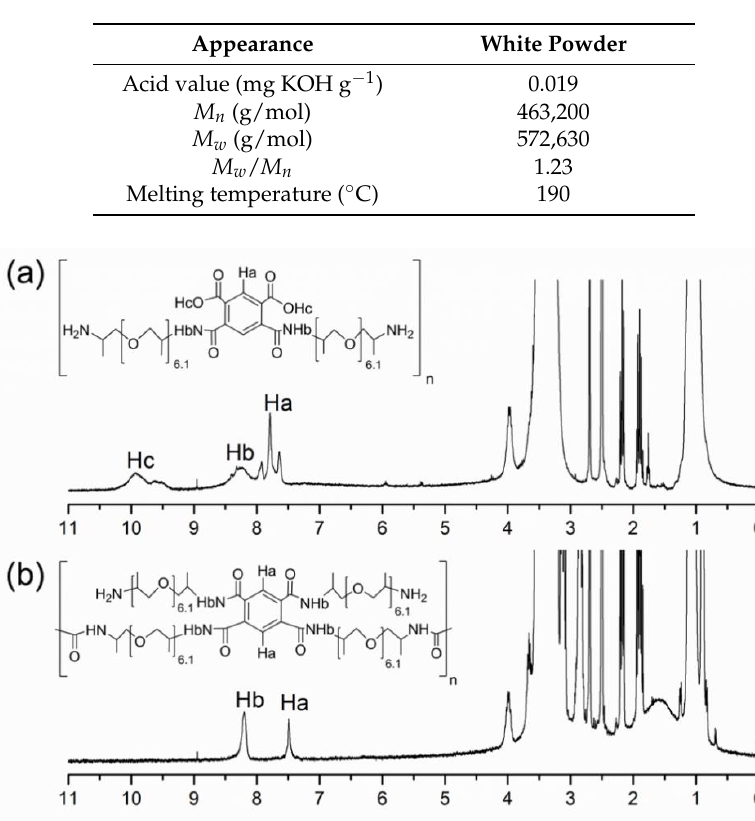
Table 2. Characterization of BTCP.